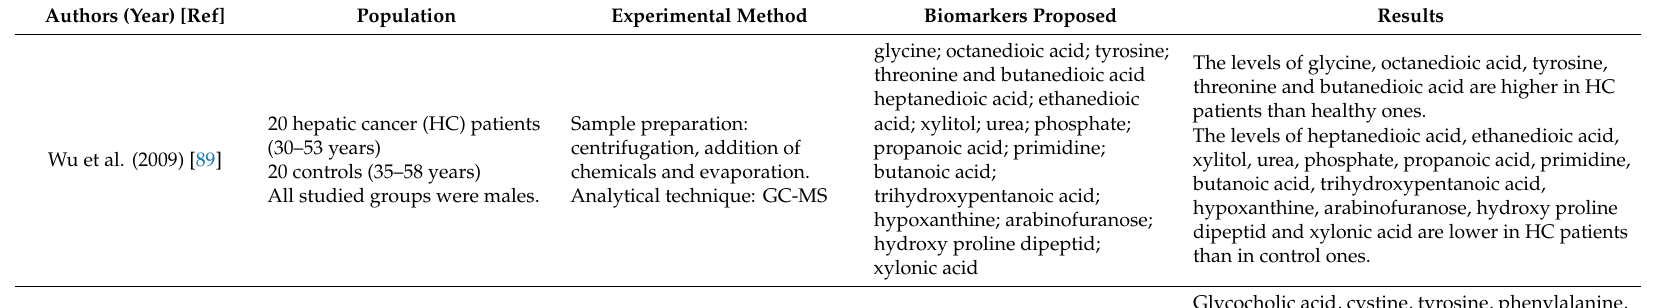
Table 6. Literary studies investigating urinary liver cancer